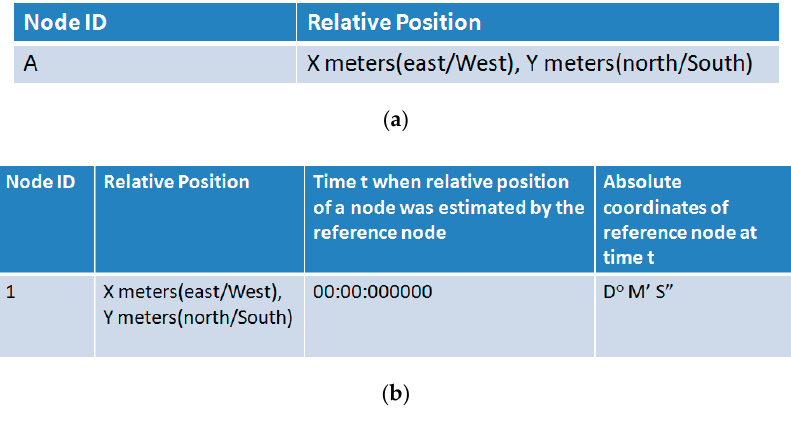
Figure 6. ( a ) TRL of an ordinary node. ( b ) TRL of reference node.